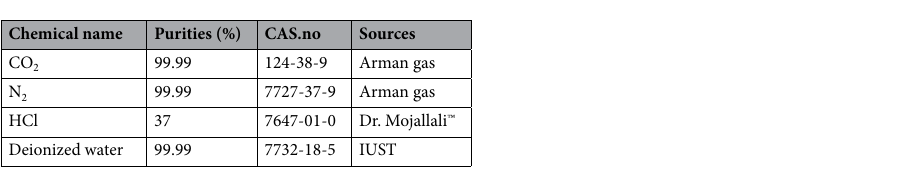
Table 1. List of chemicals and gases used in this